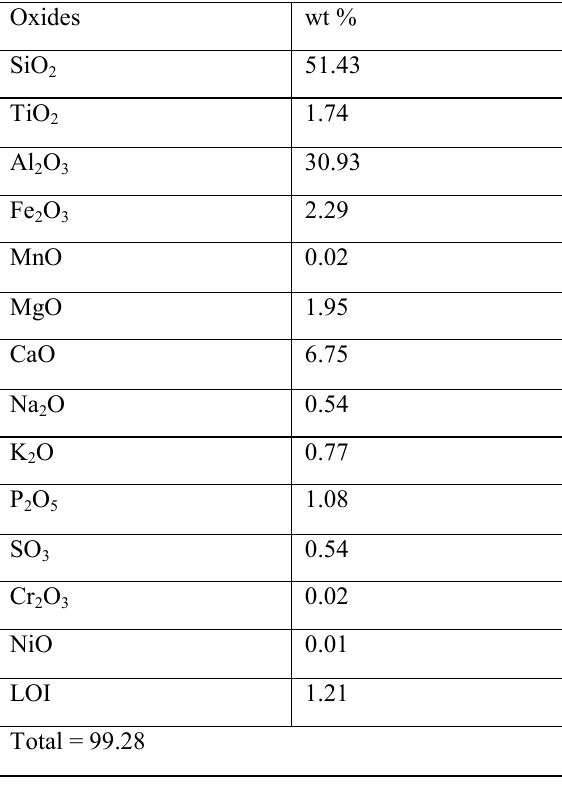
Table 2. Elemental composition of Matla